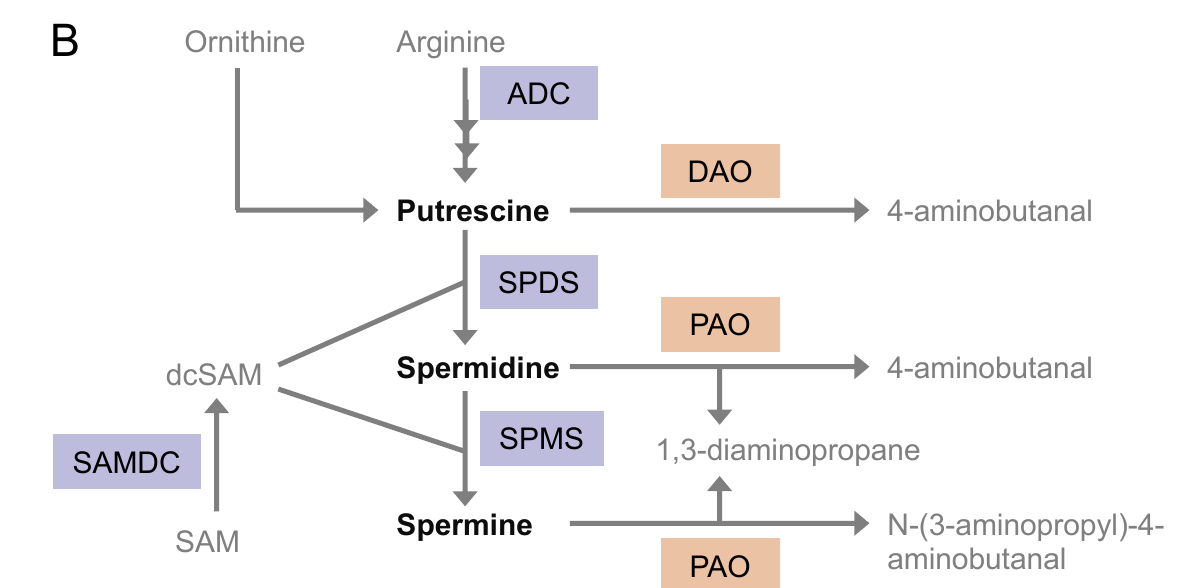
Figure 3. ( A ) Relative expression in fold change (FC) of genes involved in polyamine biosynthesis ( ADC , SAMDC , SPMS , SPDS ) and catabolism ( DAO , PAO ) in leaves of TN1.11, A17, and TN6.18 genotypes of Medicago truncatula under salt stress (200 mM NaCl) for 48 h. Results are normalized with respect to control conditions. Asterisks indicate statistically significant differences according to pairwise fixed reallocation randomization test ( p < 0.05). ( B ) Proposed biosynthetic and catabolic pathways of polyamines (Pas) in plants. Notes: ADC, arginine decarboxylase; dcSAM, decarboxylated S-adenosylmethionine; DAO, diaminoxidase; PAO, polyaminoxidase; SAM, S-adenosylmethionine; SAMDC, S-adenosylmethionine decarboxylase; SPDS, spermidine synthase; SPMS, spermine